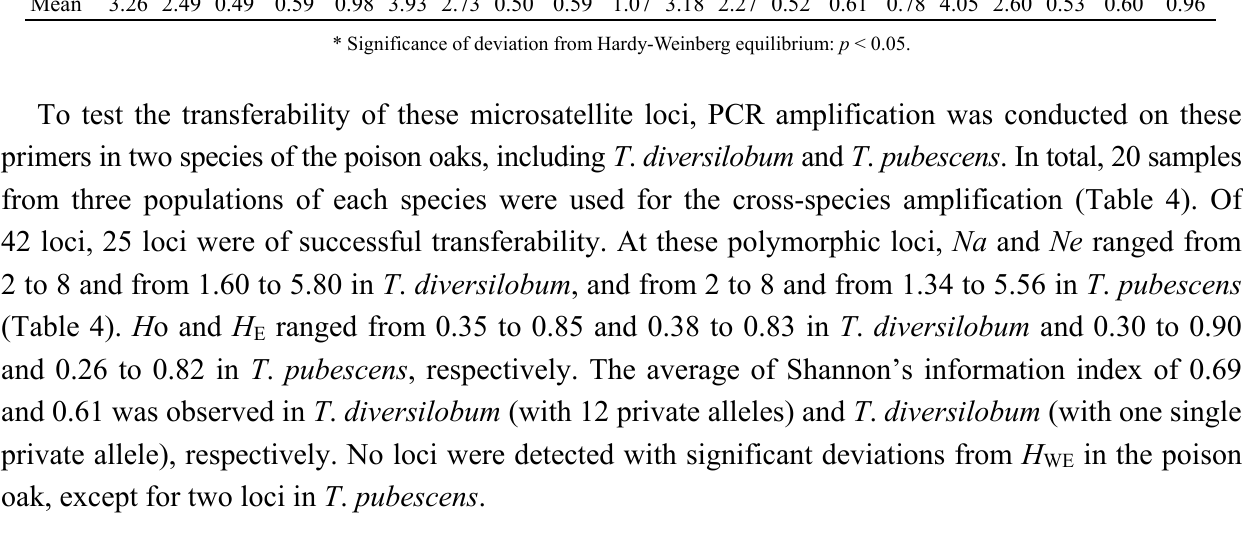
Table 4. Average genetic diversity in poison oak, Toxicodendron diversilobum and T . pubescens , at 42 loci with high transferability. For each locus, number of alleles ( N a), effective number of alleles ( N e), observed heterozygosity ( H ), and Shannon’s information index ( H ) are ( H E